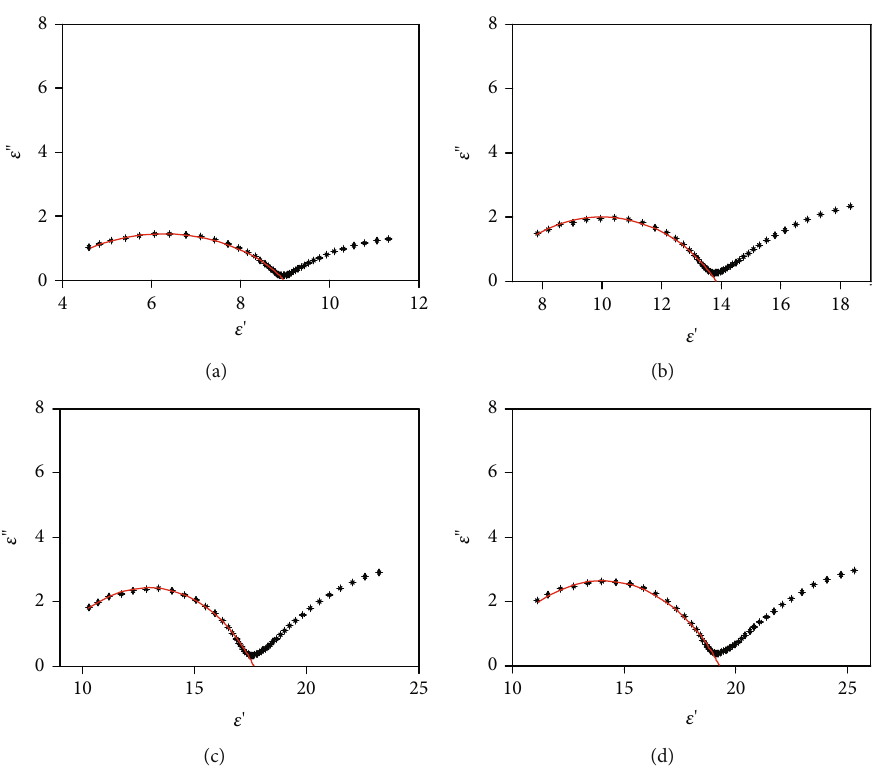
Figure 11: Cole-Cole curves of PVDF (a), BT10/PVDF (b), BT15/PVDF (c), and BT20/PVDF (d). The line represents the fi tted curve by the Cole-Cole equation. Table 4: The calculated parameters by the Cole-Cole equation.